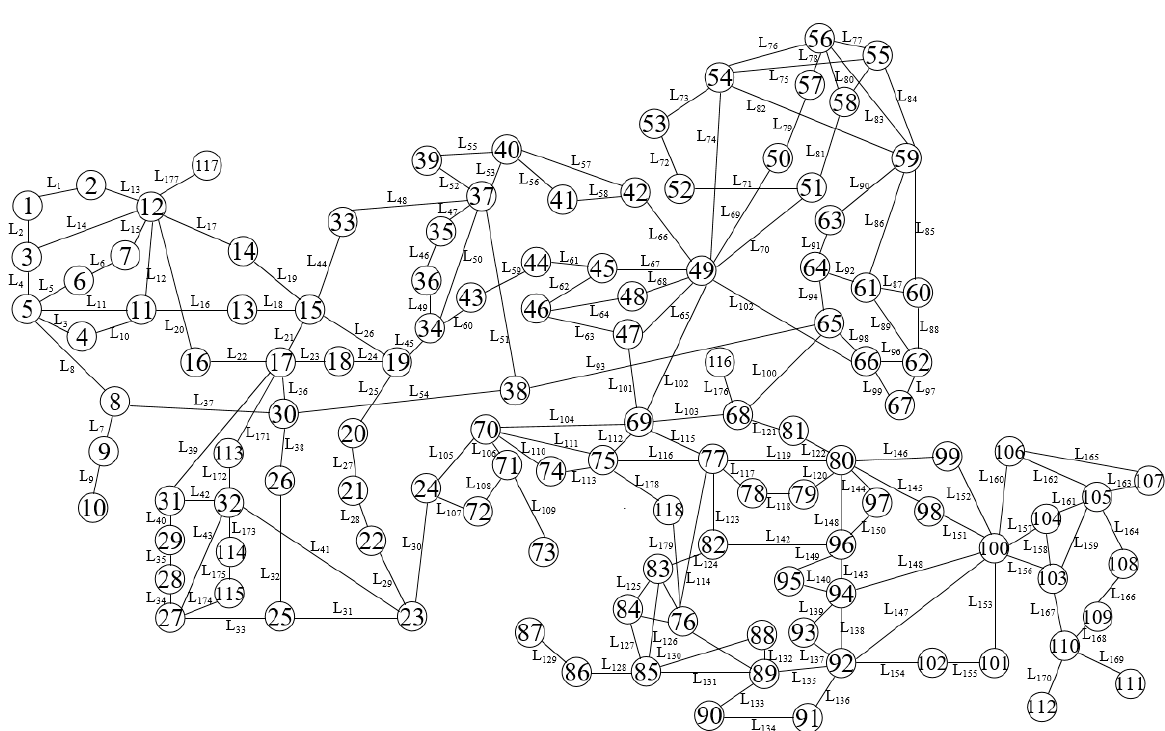
Figure 4. IEEE 118-bus power system.